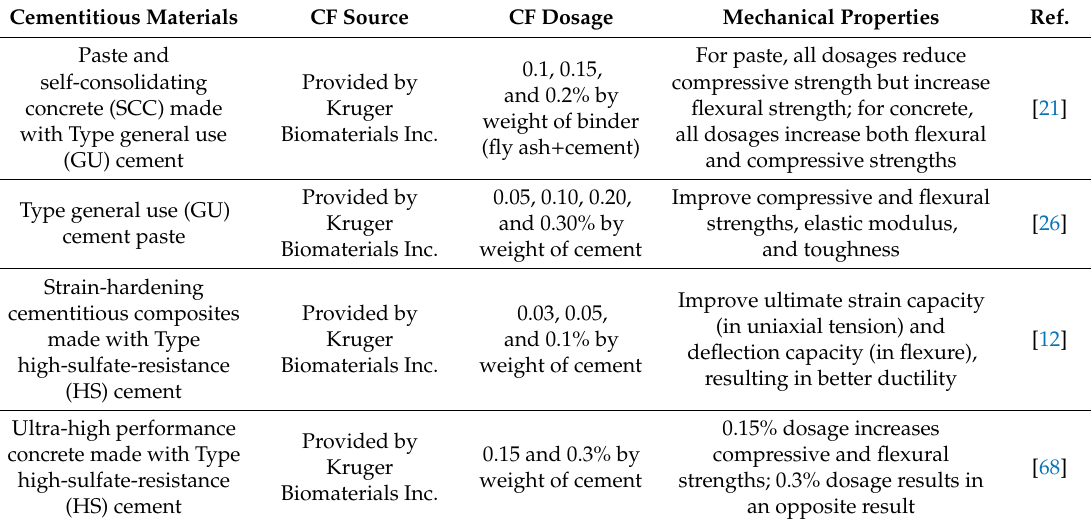
Table 4. Mechanical properties of cementitious materials with cellulose filaments